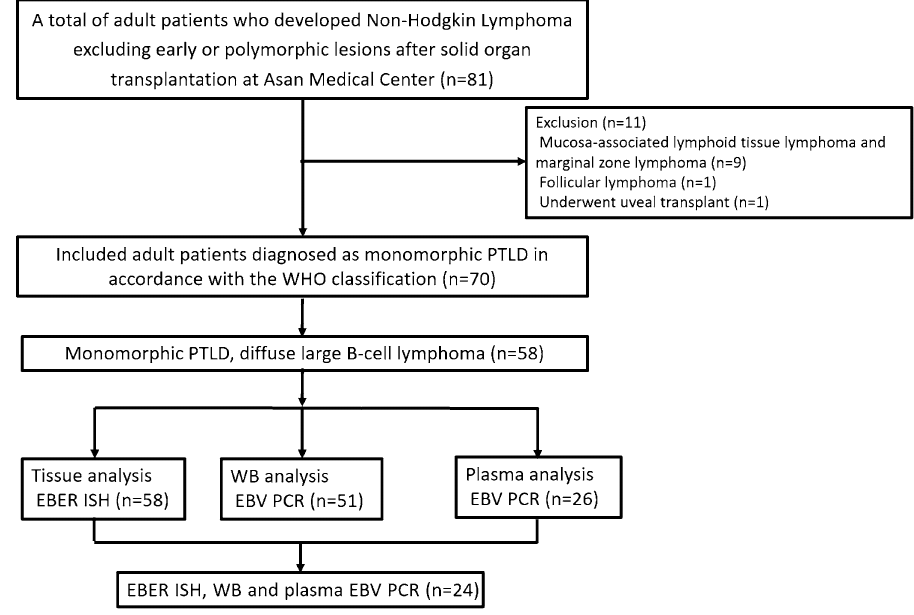
Figure 1. Consort diagram. PTLD post-transplantation lymphoproliferative disorder, WHO world health organization, EBER Epstein-Barr virus-encoded small ribonucleic acids, ISH in situ hybridization, WB whole blood, EBV Epstein-Barr virus, PCR polymerase chain